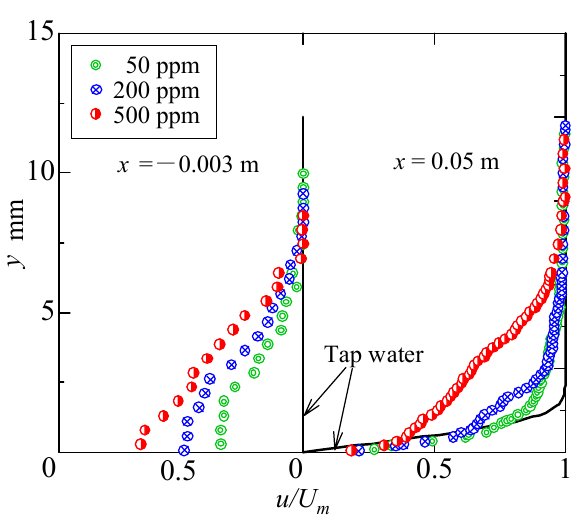
Fig. 9 Velocity profiles for surfactant solutions at x = − 0.003